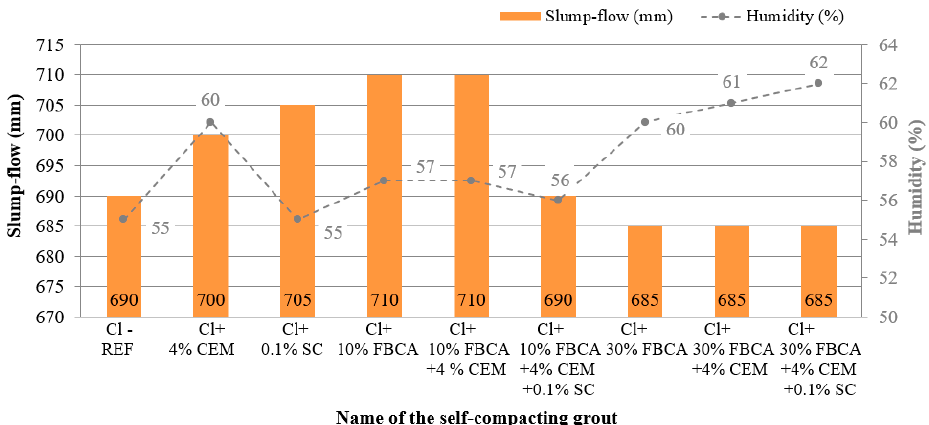
Figure 5. Slump-flow dependence on moisture of self-compacting grouts using FBCA and liquefying additive sodium carbonate.